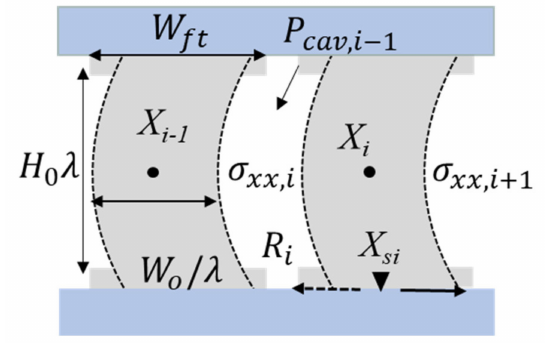
Figure 9. Force balance of i -th